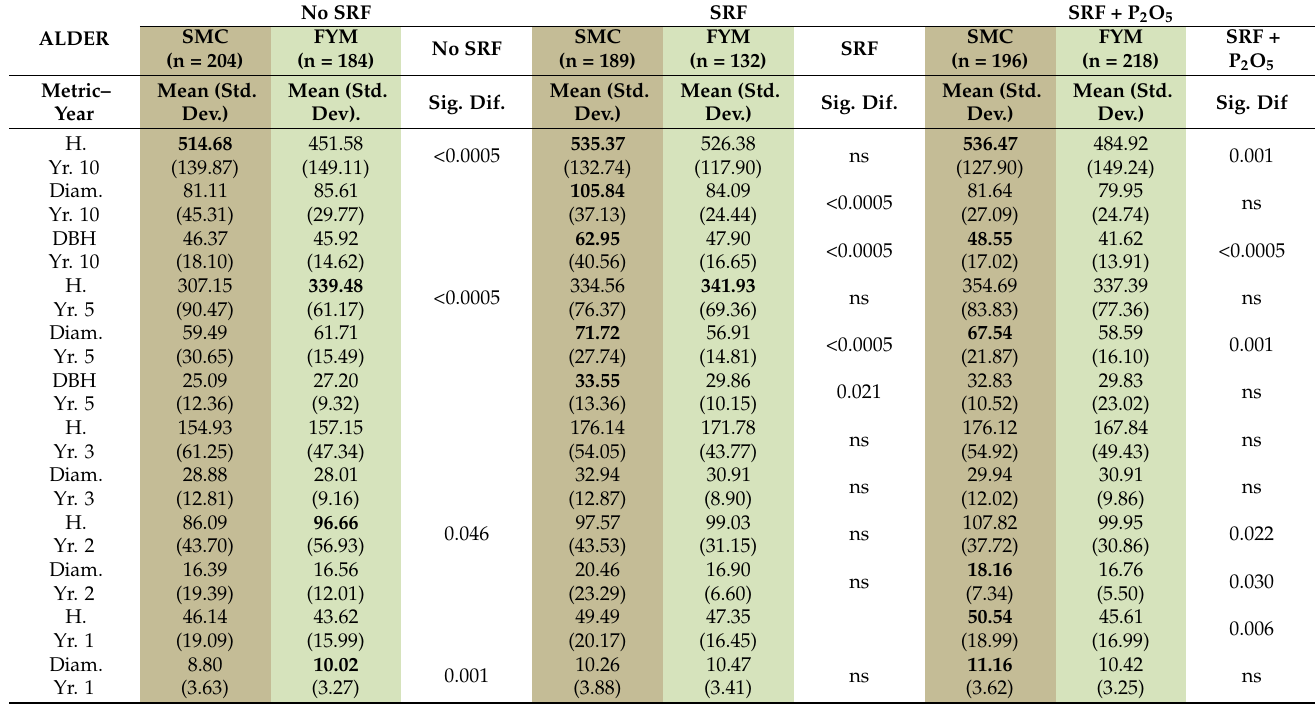
Table 10. Comparison of Alder growth with SMC or FYM planting compost and fertilizer. (Nb: height (H) cm; DBH: mm, Diam. (diameter above root collar): mm, ratio FYM/SMC, ns: differences not significant). No SRF